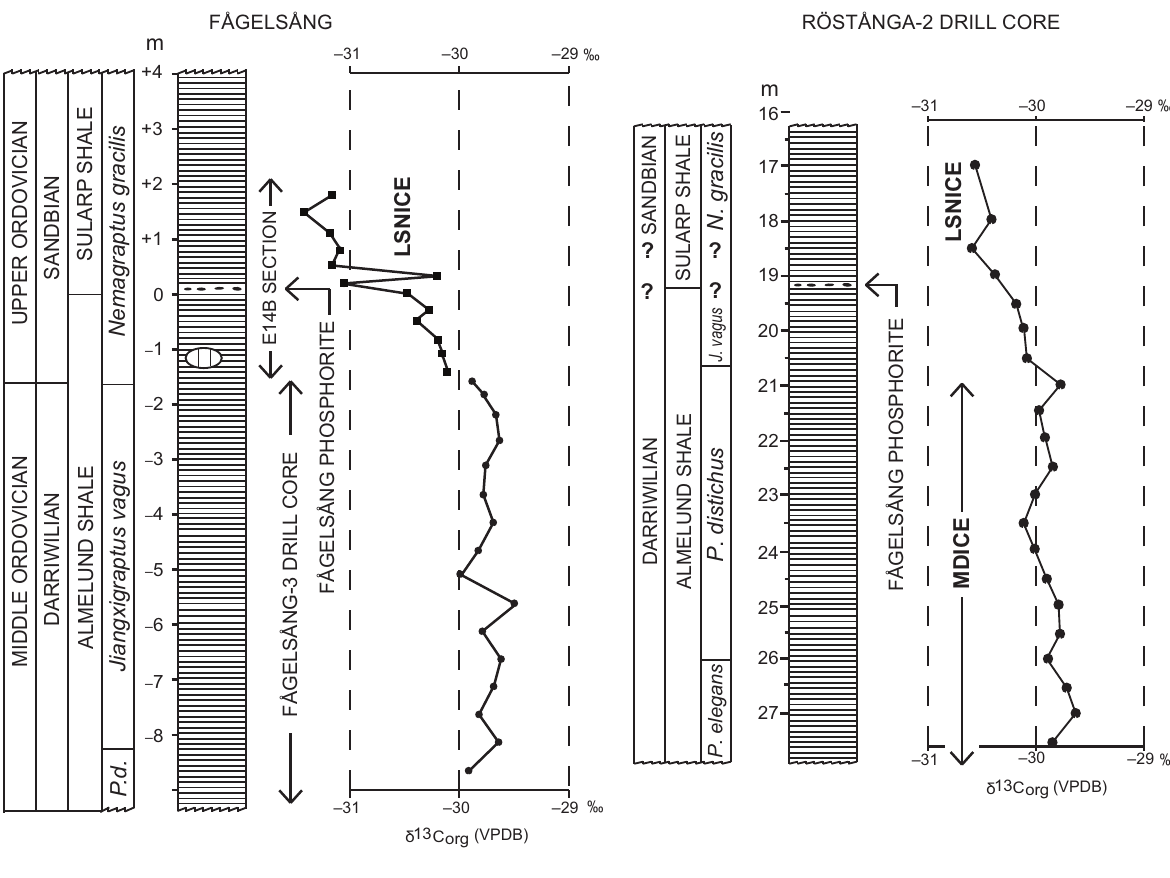
Fig. 6. Comparison of the uppermost Darriwilian–lowermost Sandbian interval (from the top of the Pseudamplexograptus distichus Zone to the lower Nemagraptus gracilis Zone) in the Röstånga­2 drill core and at Fågelsång. The latter is a composite of part of the Fågelsång­3 drill core (Bergström et al. 2018, fig. 5) and the E14b outcrop (Bergström et al. 2020, fig. 5), this outcrop section being the GSSP of the Global Sandbian Stage. Note the general similarity between the isotope curves. Three apparently anomalous data points just above the Fågelsång Phosphorite in the Röstånga­2 drill core (see Table 1) are omitted in this figure. The isotope curves suggest that in terms of δ 13 C chemostratigraphy, the base of the Sandbian Stage occupies a position between the positive curve perturbation referred to as MDICE and the negative one known as LSNICE. P . d., Pseudamplexograptus distichus